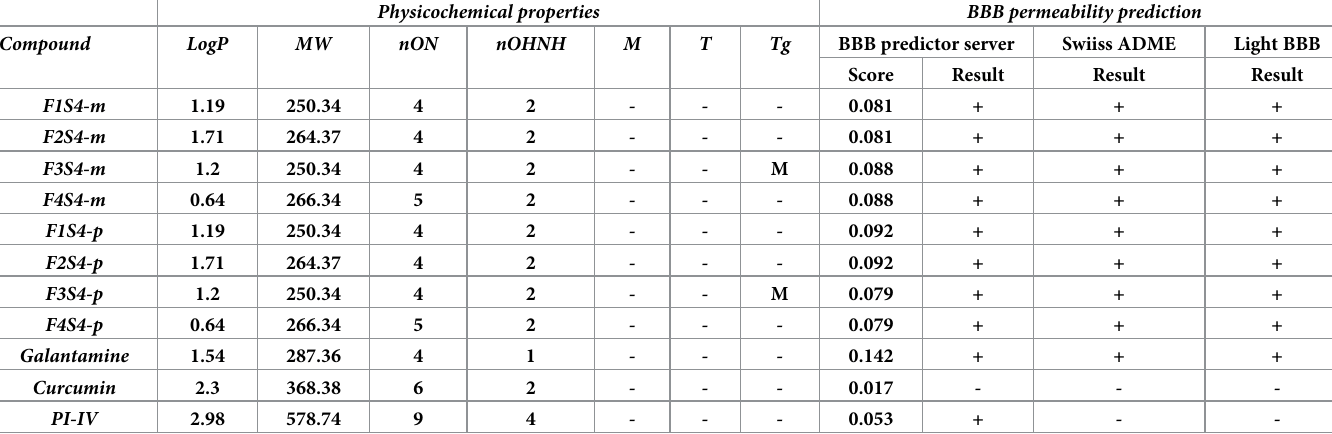
Table 1. In silico properties, biological activity prediction and Blood Brain Barrier (BBB) permeability prediction Log P (bipartition coefficient) MW (molecular weight); nON, (number of hydrogen bond acceptors); nOHNH (number of hydrogen bond donors); Mt (mutagenicity); Tg, (teratogenicity), T (tumorigenic). Physicochemical